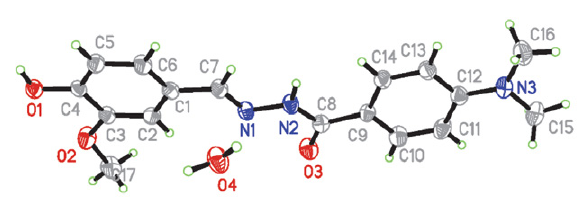
Figure 2. A perspective view of the molecular structure of 2 show- ing the atomic labeling scheme. The thermal ellipsoids are drawn at the 30% probability level.